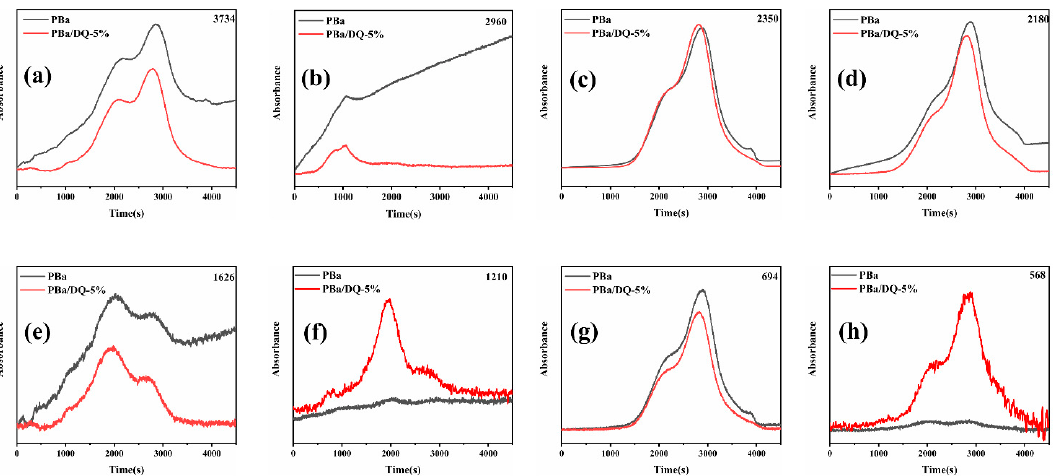
Figure 12. FTIR spectra of ( a ) PBa; ( b ) PBa/DQ-5% at different temperatures.